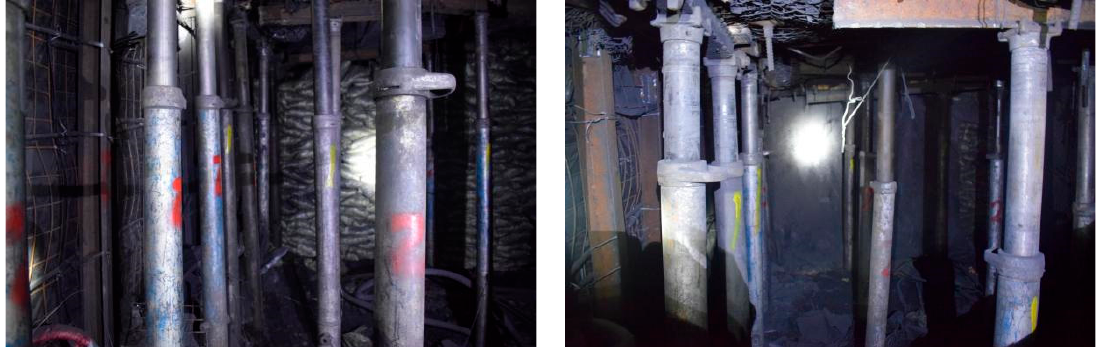
Figure 18. Effect of on-site delayed temporary support.